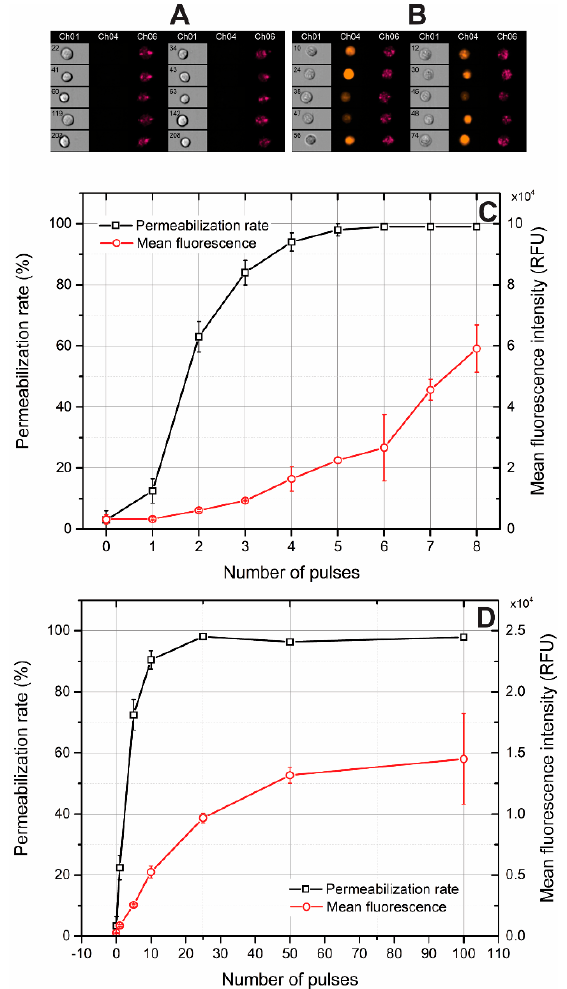
Figure 2. Permeabilization of Sp2/0 cells by pulsed electric fields, where A ) photographs of untreated cells; B ) photographs of cells treated by 3.5 kV/cm × 800 ns × 100 pulses; C , D ) permeabilization curves of cells treated by 1.4 kV/cm × 100 µs and 3.5 kV/cm × 800 ns pulsing protocols, respectively. Ch01—brightfield image; Ch04—propidium iodide fluorescence image at wavelength of 488 nm; Ch06 — image of forward side scatter.